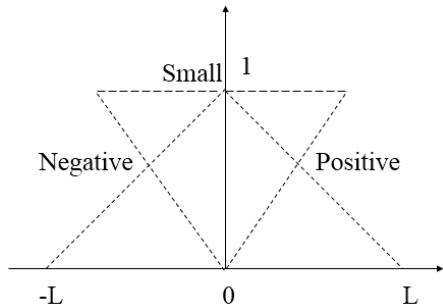
Figure 4: Graphical illustration of membership function